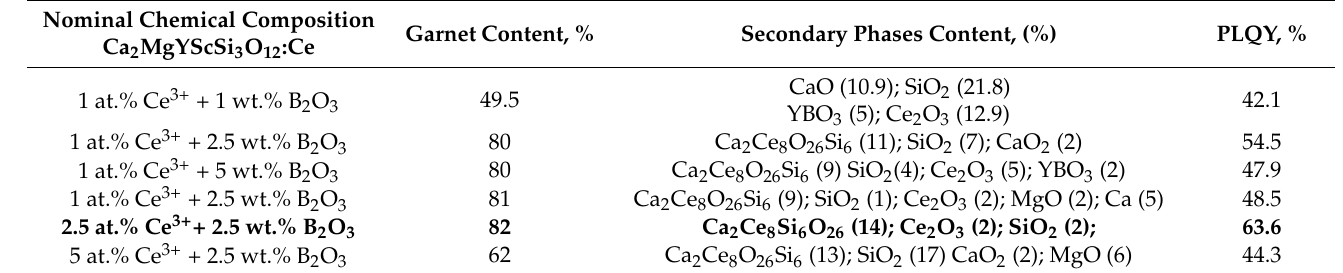
Table 1. The garnet/secondary phase proportions and PLQY of the CYMSSG:Ce MPs sintered with different flux and activator